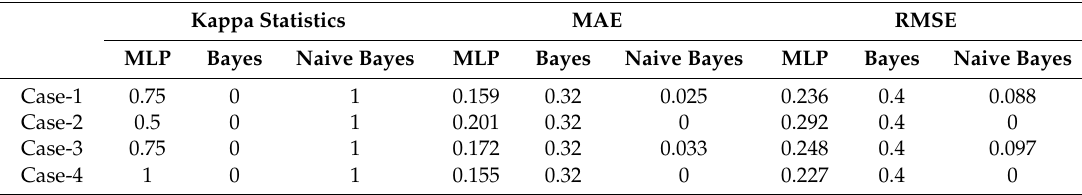
Table 9. Performance comparison of various Classifiers.